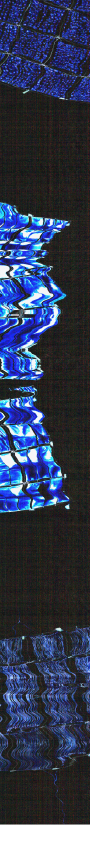
Figure A3. Waterfall image of the flyby analyzed from the 25/9 Grifo-X flight 1. In Figure A4 is possible to see the obtained results for all the targets.